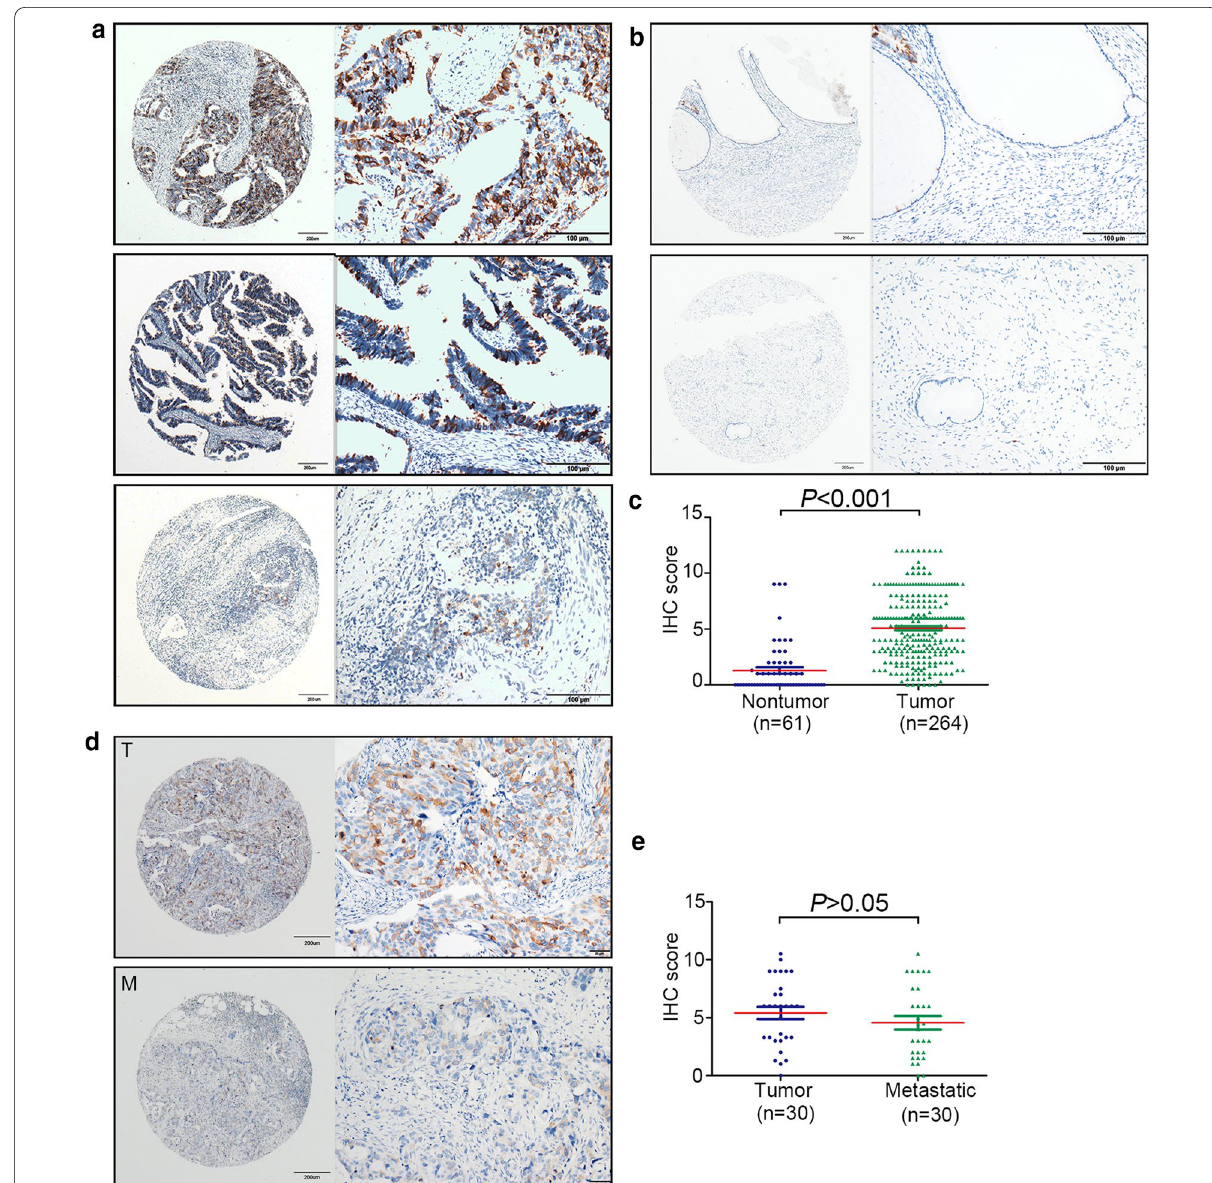
Fig. 1 Overexpression of TACC3 in endocervical adenocarcinoma (ECA) detected by immunohistochemistry (IHC). a Representative staining for TACC3 in a tissue microarray (TMA) cohort. Representative images of strong, moderate,and weak intensity staining for tumor tissues are shown. b Representative IHC images of positive and negative non‑tumor tissues are presented. c According to IHC scores of the TMA cohort, TACC3 expression in ECA was significantly higher than that in non‑tumorous tissues. d TACC3 expression in 30 ECA cases with lymph‑node metastasis (LNM). Representative graphs are shown for primary tumor (T) and metastatic (M) lesions. e Comparison of TACC3 levels between primary tumor and metastatic lesions. Quantitative data are presented as the mean standard deviation ±